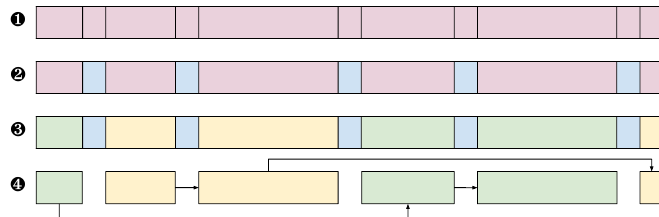
Figure 3: Visualization of control-flow extraction for two tasks. We first identify contiguous regions of viable control-flow in the input trace (step (cid:182) ), then identify task switching and interrupt handling logic (shown in blue in step (cid:183) ), identify the control-flow for each task (task 1 shown in green and task 2 in yellow in step (cid:184) ), and finally, perform task-level CFG extraction (step (cid:185)